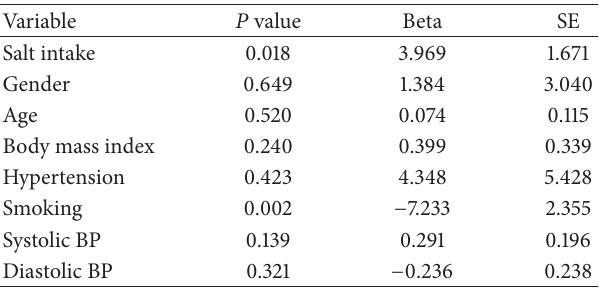
Figure 2: Correlation between 24-hour urinary sodium secretion and level of urine albumin (beta = 0.130, 𝑃 < 0.001 ). Table 2: Association between salt intake and albuminuria in a linear regression